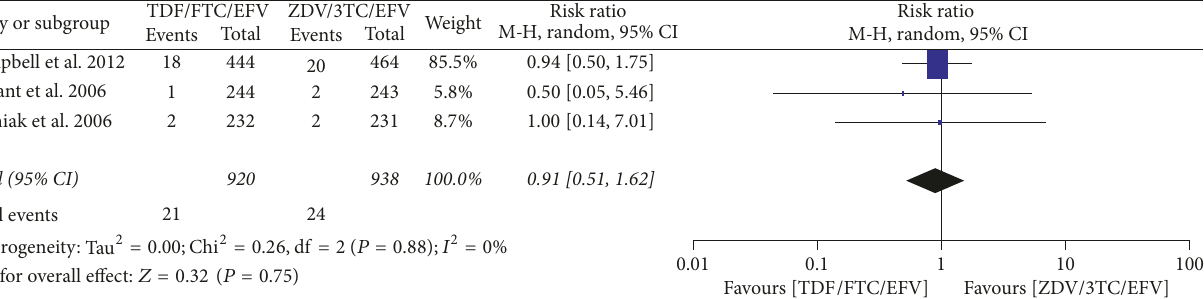
Figure 4: Forest plot of mortality effect of TDF arm as compared to ZDV arm in ART na¨ıve HIV-1 infected patients.